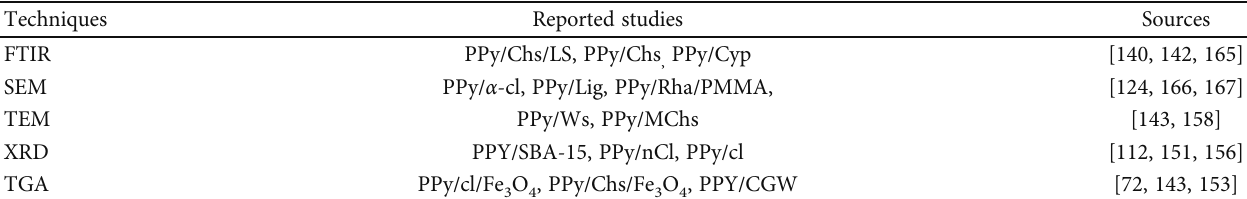
Table 8: Summary of characterization techniques used for PPy/agro waste composites reported in this review.